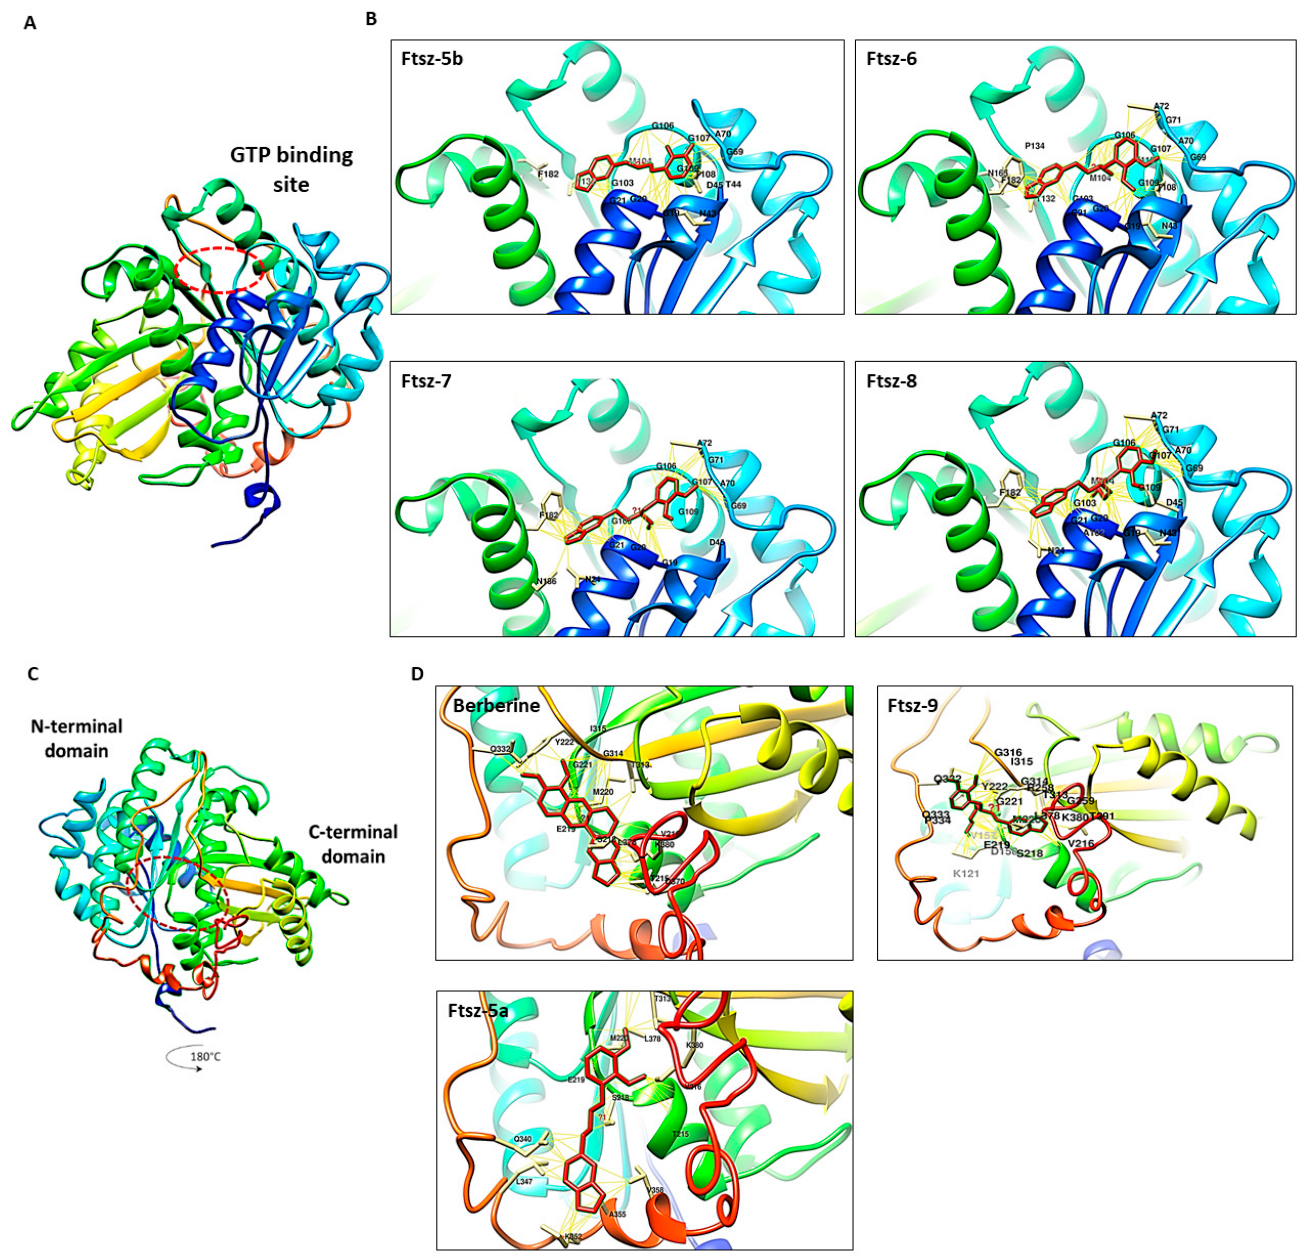
Figure 3. ( A ) FtsZ model obtained with I-TASSER Server; ( B ) predicted interactions between FtsZ and compounds 5b , 6 – 8 ; ( C ) FtsZ rotation of 180 ◦ ; ( D ) predicted interactions with berberine and compounds 5a , 9 . The interactions prediction was obtained using the Protein-Ligand Interaction Profiler (PLIP) Server. The residues involved in the interaction and the connection between the residues are in yellow. Images were generated by the CHIMERA software.